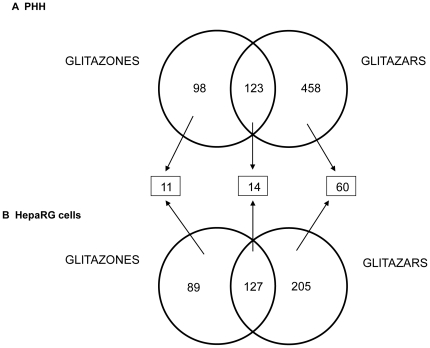
Venn diagram representation of differentially expressed genes in glitazone- and glitazar-treated hepatocytes.Venn diagrams showed overlap of gene signatures (FC≥1.5 and p≤0.01) in at least two concentrations of each glitazone and glitazar in PHH (a) and HepaRG cells (b).